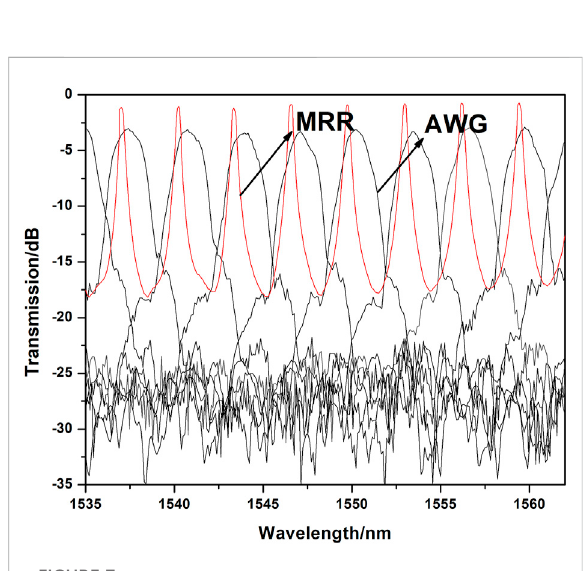
FIGURE 7 Transmission spectra of conventional AWG and